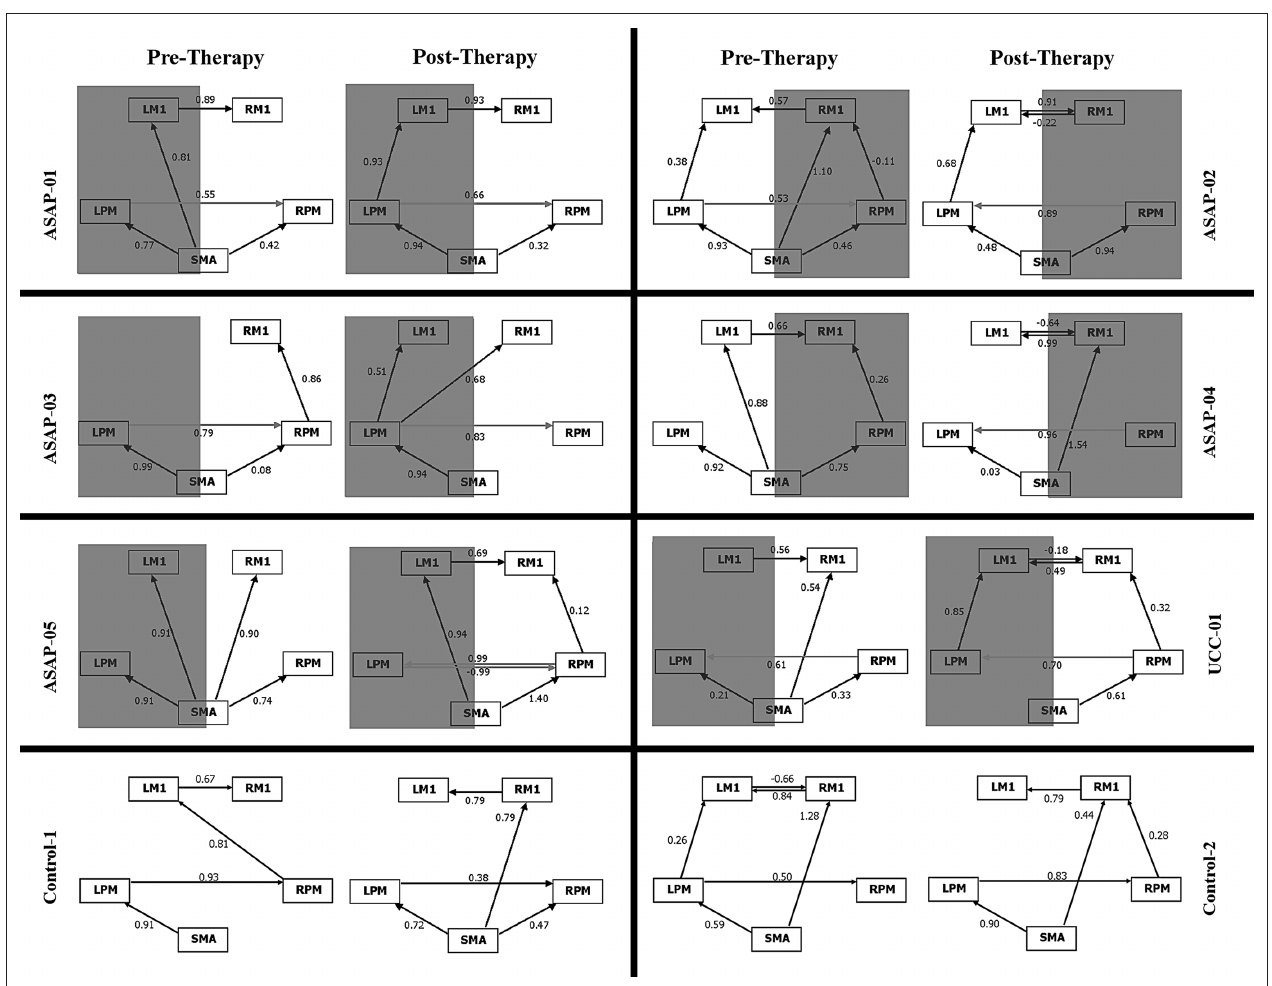
left primary motor cortex; RM1, right primary motor cortex; LPM, left premotor cortex; RPM, premotor cortex; SMA, supplementary motor area. Reproduced with permission from James et al. (2009). Thomas Land Publishers,